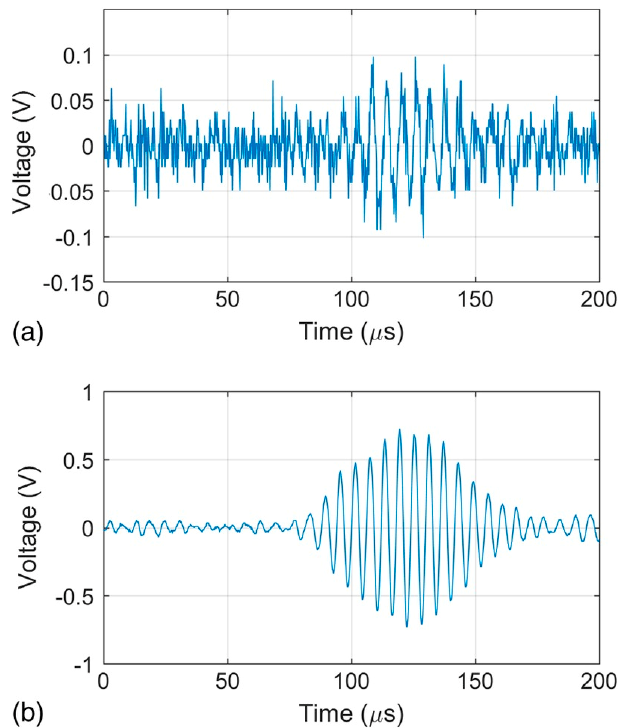
Figure 18. Comparison of signals from air-coupled receivers due to leaky surface acoustic waves from a rail section, ( a ) without impedance matching and ( b ) with impedance matching. Reproduced with permission from Reference [13], Copyright ASCE, 2017.